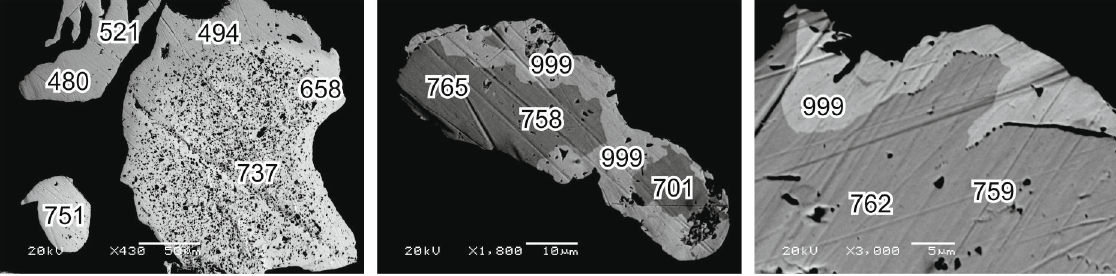
Figure 10. Heterogeneous of supergene gold (the numbers show the degree of fi neness).